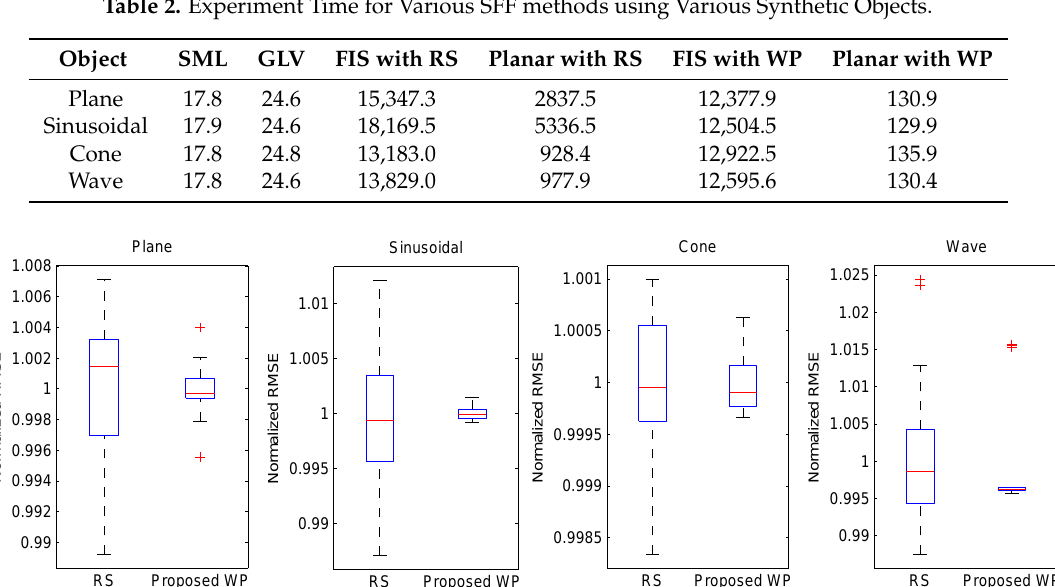
Table 2. Experiment Time for Various SFF methods using Various Synthetic Objects.